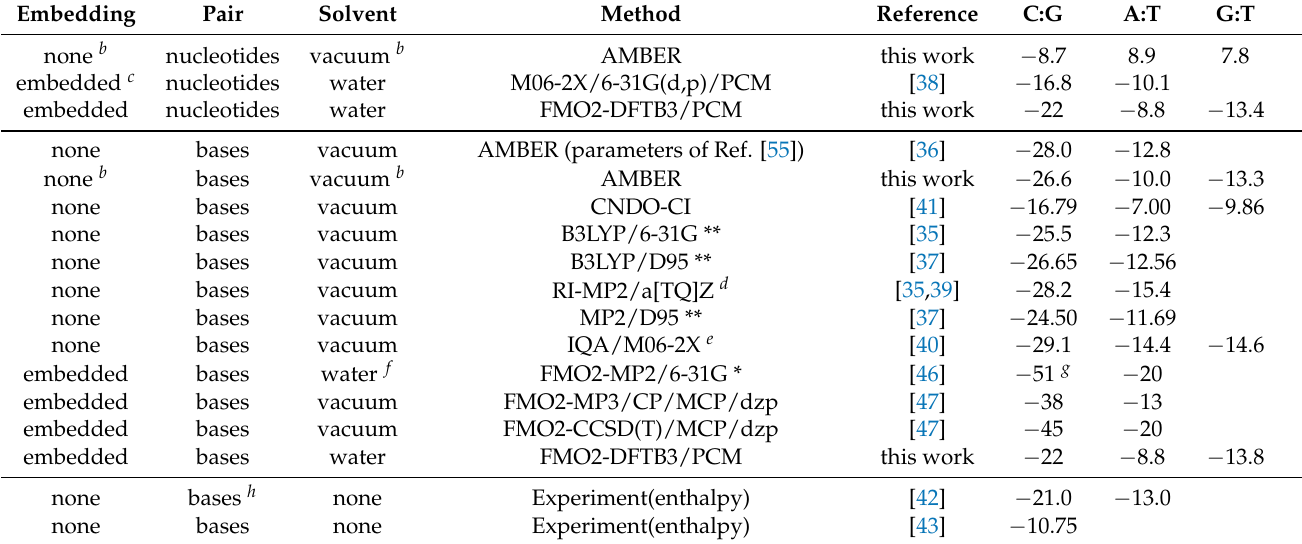
Table 7. Association energies a (kcal mol − 1 ) for neutral Watson–Crick base pairs and anionic